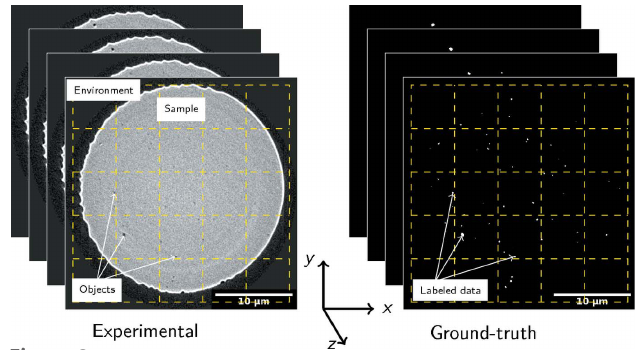
Figure 2 TXM synchrotron experimental result and ground-truth (manually segmented) images with 1024 (cid:3) 1024 (cid:3) z voxels from a (cid:5) 25 m m- diameter micropillar extracted from an additively manufactured 316L stainless steel sample ( z represents the number of slices along its direction, e.g. four in the figure). Dashed yellow squares represent the 192 (cid:3) 192 (cid:3) 192 voxels sub-volumes used to train the neural